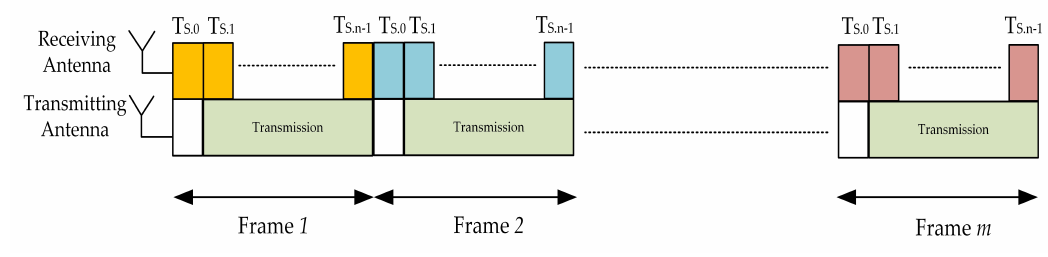
Figure 3. Time-slotted frame structure of FD-SU